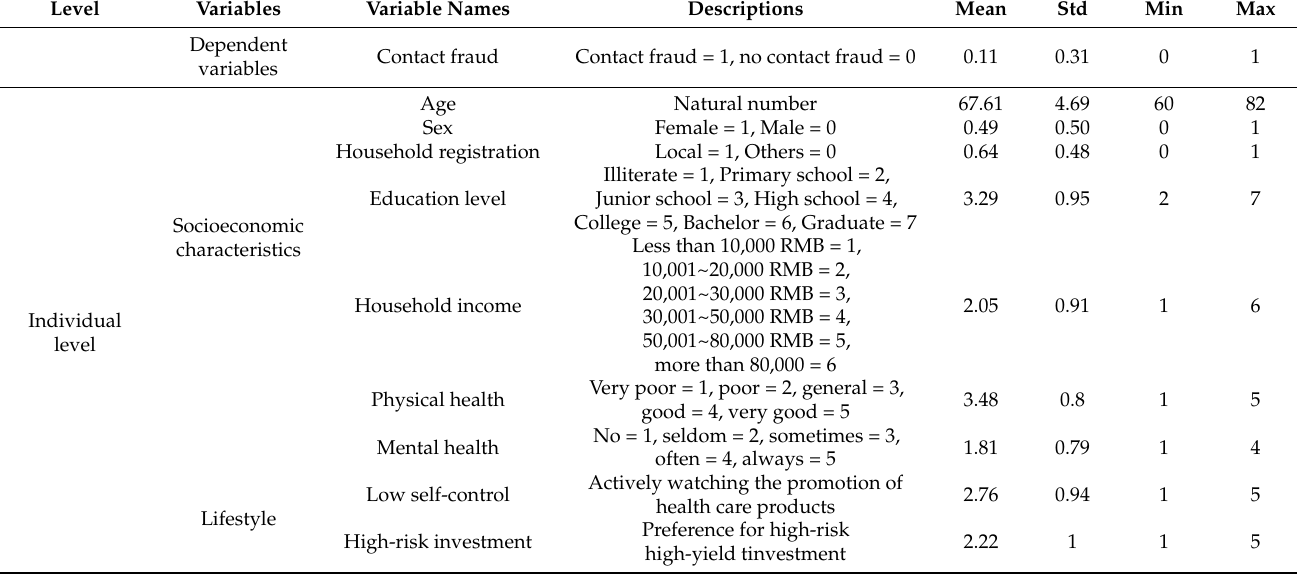
Table 2. Descriptions and statistics of